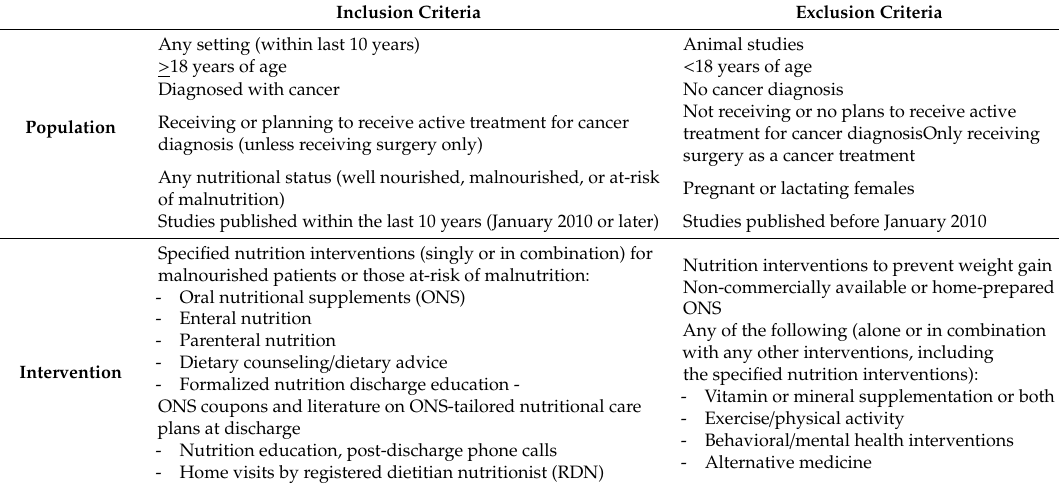
Table 2. Summary of inclusion and exclusion criteria to identify studies involving early incorporation of nutrition interventions as a component of cancer